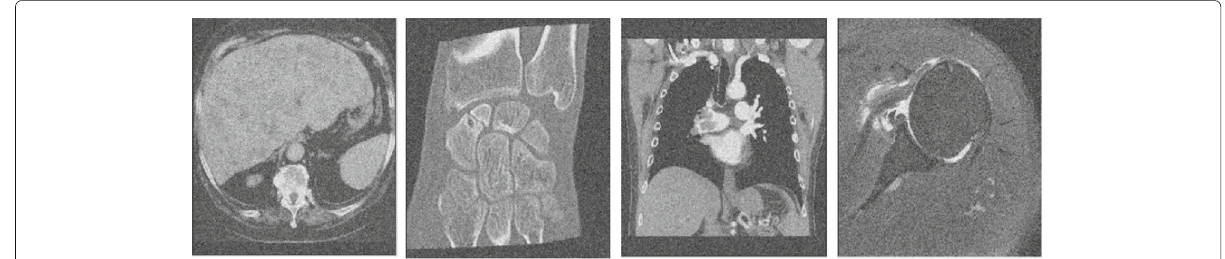
Fig. 2 Images corrupted by Gaussian noise with zero mean and variance σ 2 = 0.025